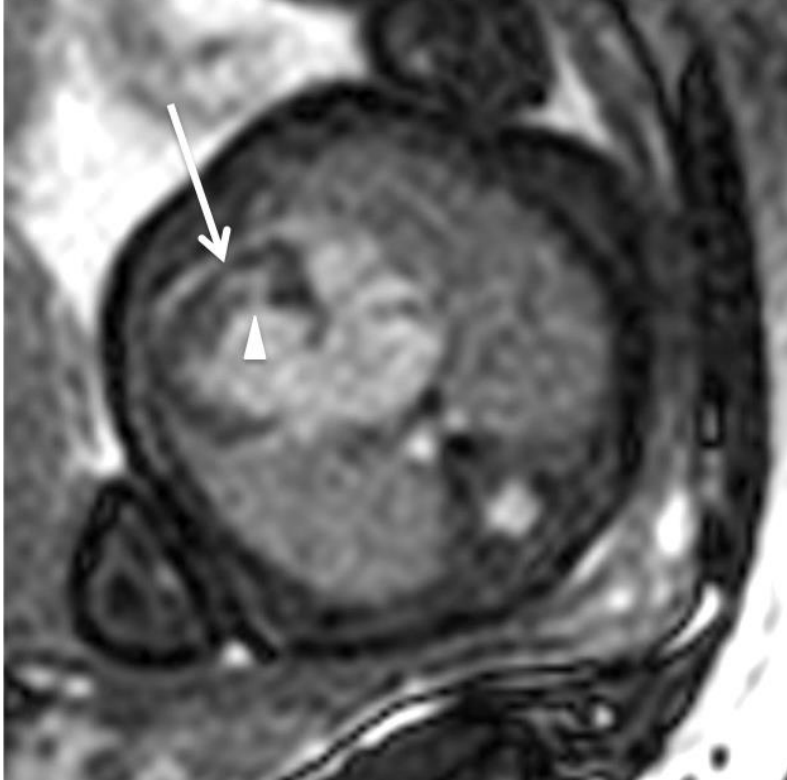
Figure 2. Fetal cardiac MRI using Doppler ultrasound gating for assessment of dynamic/cine steady- state free-precession (SSFP) sequences (TR = 3.3 ms, TE = 1.6 ms, field of view = 300 × 300 mm, flip angle = 60°, slice thickness = 5 mm, matrix size 288 × 288) at 1.5 Tesla: The end-diastolic four-chamber SSFP image illustrates hypoplastic right heart (arrow) and ventricular septal defect (arrowhead) in a late term fetus (gestational age: 30 + 5 weeks). Postnatal diagnosis revealed atresia of the tricuspid valve, malposition of the great arteries, and interrupted aortic arch (not visualized in the presented four-chamber view).